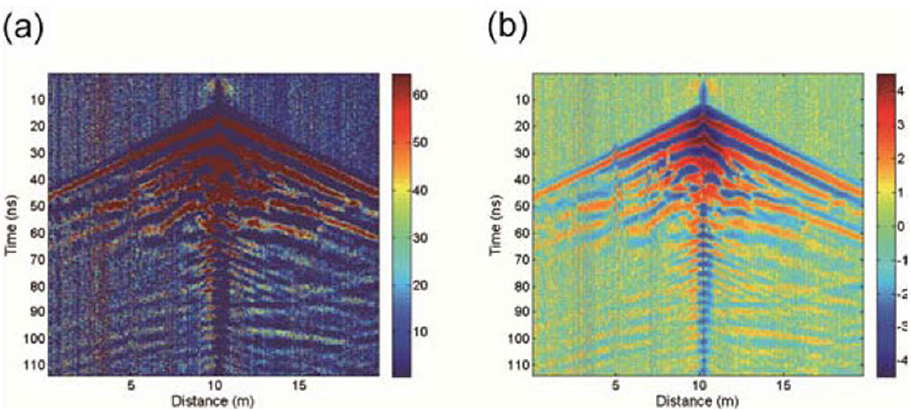
Fig. 10. GPR shot gather data. (a) Original GPR data showing refraction and reflection events and harmonic noise. (b) Logarithmic transform of original GPR data.